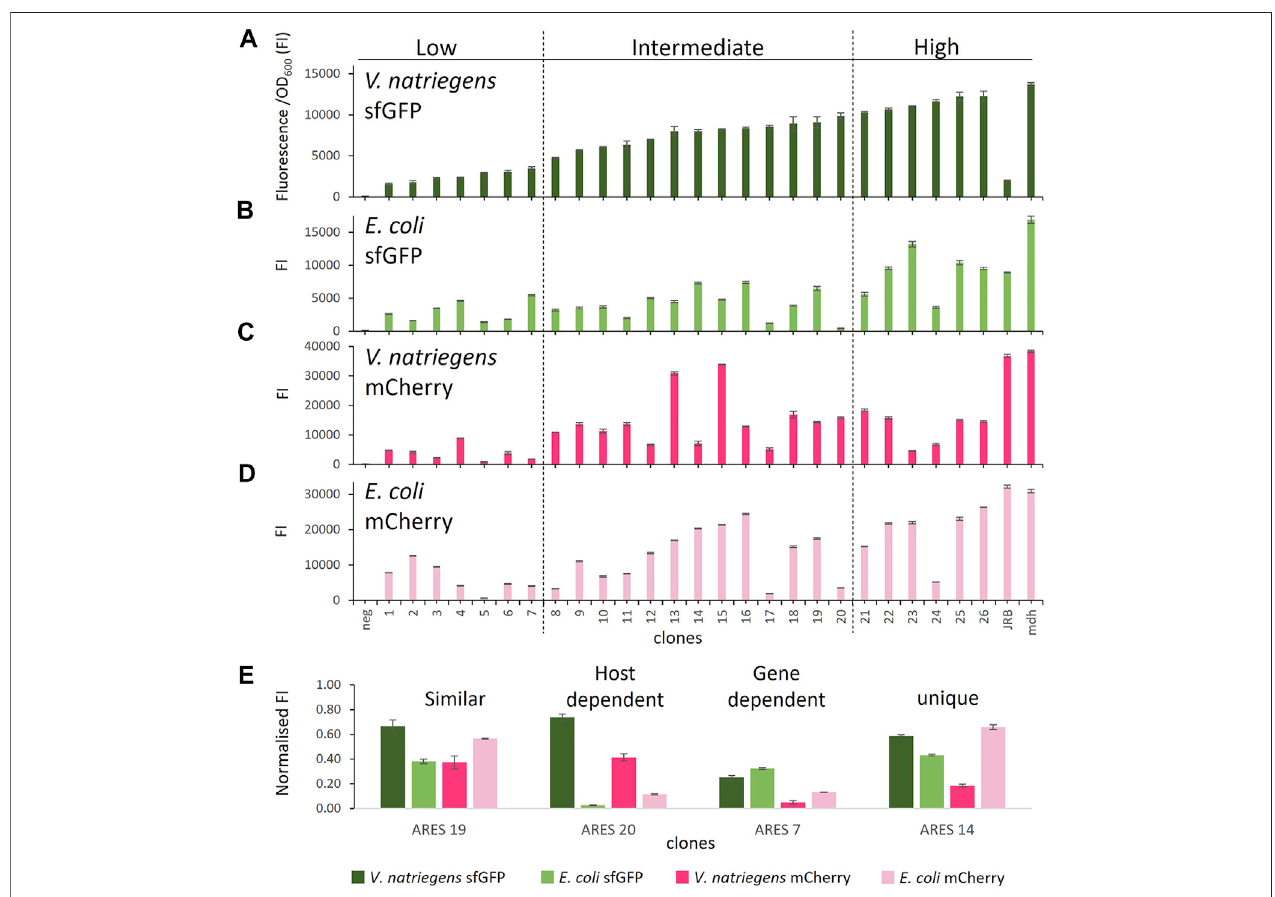
FIGURE 2 | Comparison of FI in the different host-reporter combinations grown in rich medium: (A) V. natriegens clones expressing sfGFP, (B) E. coli clones expressing sfGFP, (C) V. natriegens clones expressing mCherry, (D) E. coli clones expressing mCherry, (E) clones representing different observed expression patterns. FI* stands for fl uorescence intensity = fl uorescence/OD 600 . The clones were arranged by sfGFP FI in V. natriegens and divided into three categories based on low, intermediate, and high FI compared to the positive control. Error bars indicate the standard deviation of three biological replicates. The outline of the fi gure was inspired by Wu et al. Wu et al.